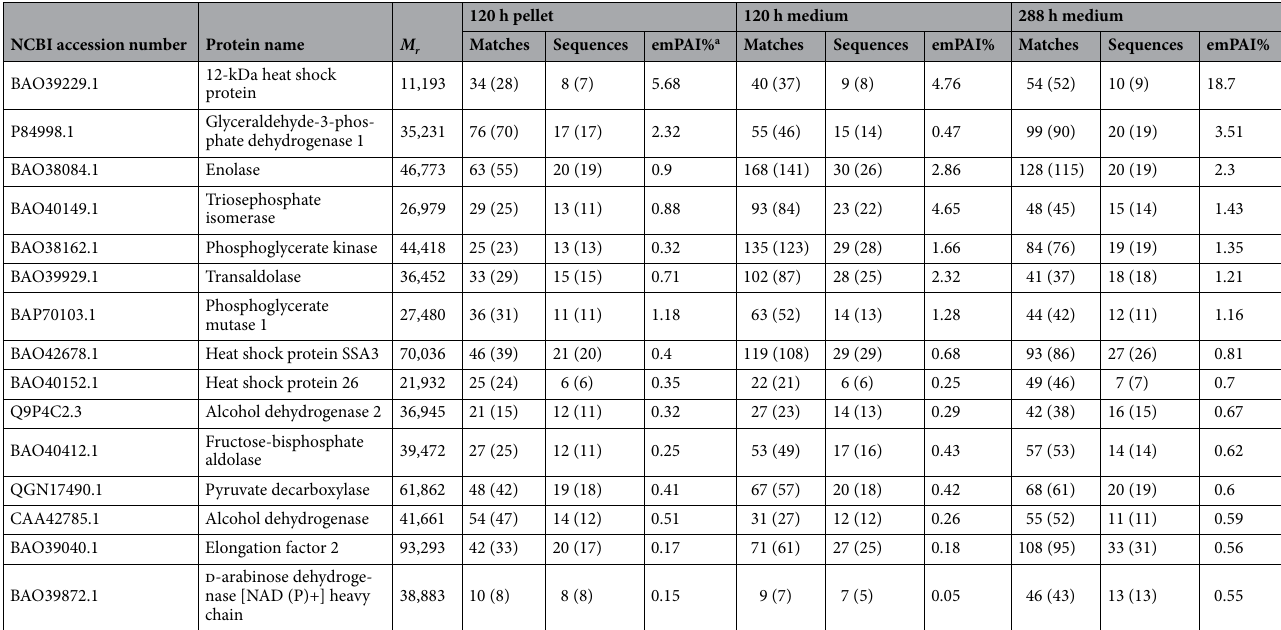
Table 2. The 15 most abundant proteins in the 288-h samples from LC–MS/MS analysis. a The emPAI% is presented as the mean of at least three